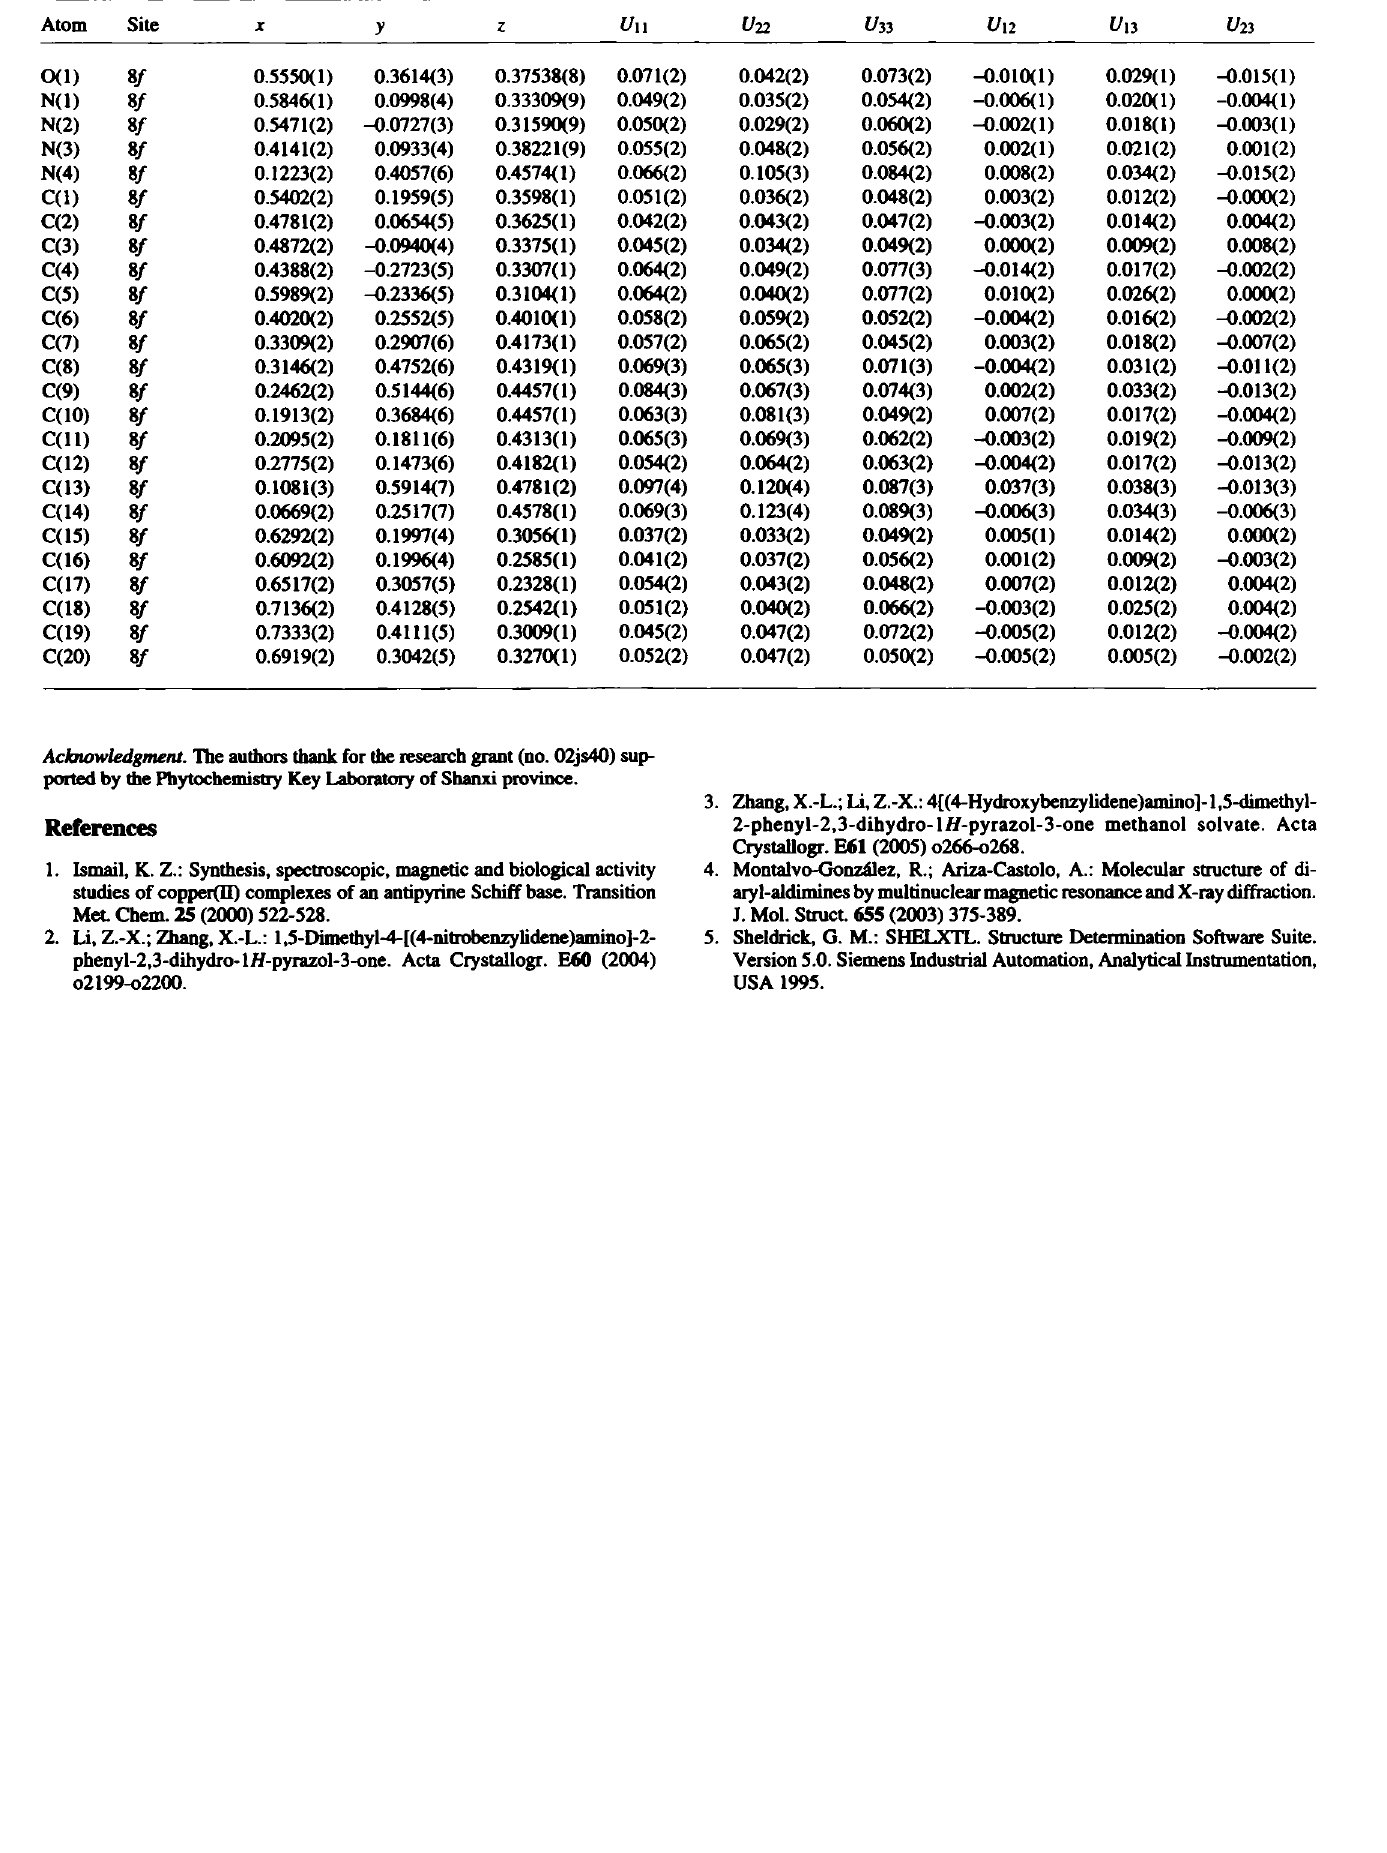
Table 3. Atomic coordinates and displacement parameters (in A 2